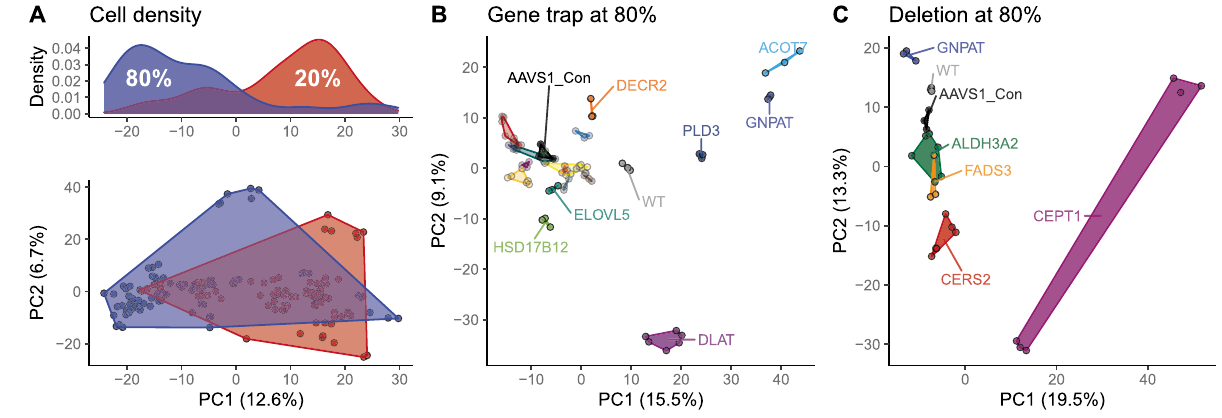
Figure 2. Principal component analysis: ( A ) Lower panel: Score plot of a PCA on all lipids occurring in every replicate of at least one cell line and density (n = 1809), colored by cell density, i.e., 20% or 80% confluency in the petri dish. Missing values were imputed with the median and only samples for which both densities were available were used. Percentages of variability explained in each principal component are indicated in the axis labels. Upper panel: Density of cell density in samples along principal component 1 (PC1). ( B ) PCA score plot of the PCA using all lipids occurring in every replicate of at least one cell line (n = 1449). Only samples that were generated at 80% confluency with the gene trap method are used. Samples are colored by gene targeted. Note that some genes are represented with one clone (a total of 3 replicates), while other genes are represented by two clones (a total of 6 replicates). Genes well separating from the bulk and control samples are highlighted and named. The percentage of variability explained in each principal component is indicated in the axis labels. ( C ) Same as B (n lipids = 1590) but containing samples that were generated with the deletion